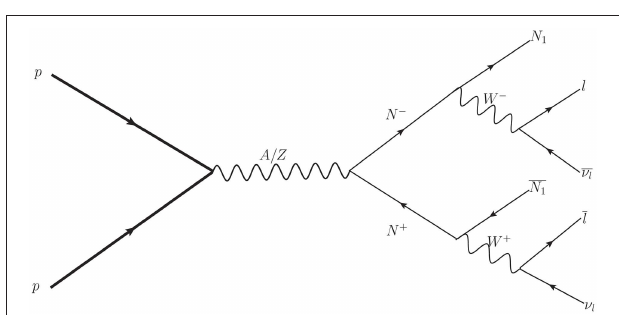
FIGURE 29 | Variation of relic density with DM mass m N by PLANCK. Displaced vertex ( Ŵ − 1 ) is plotted as a function of m N (right panel). For the displaced vertex we choose the set of parameters satisfying relic density from the left panel figure.